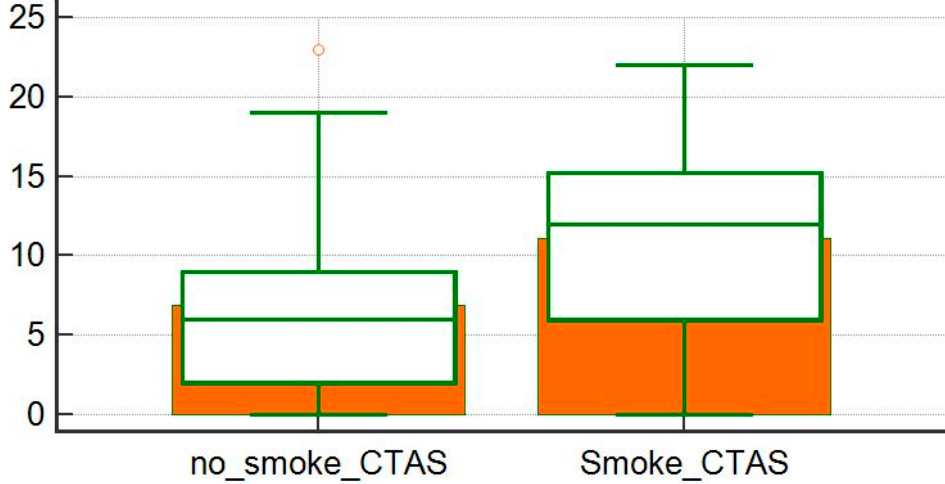
Figure 4. Comparison of computer tomography activity score (CTAS) averages between exposed and non-smoking patients.